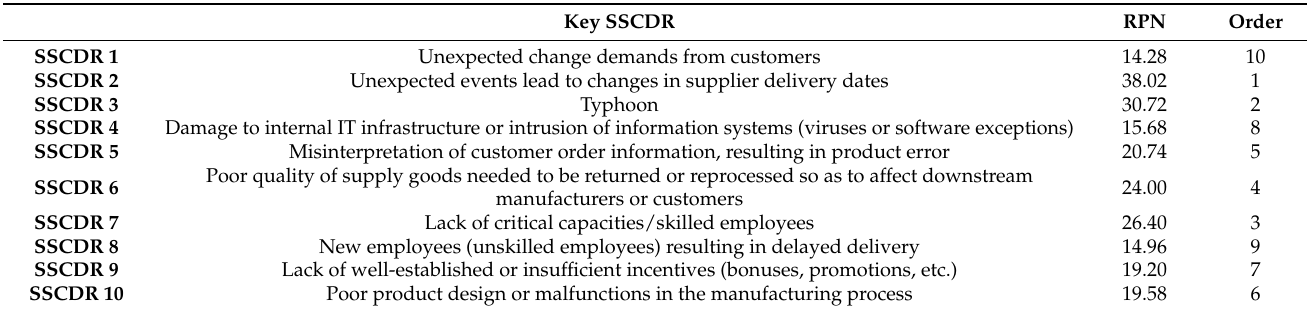
Table 3. FMEA screening results of key SSCDRs and RPNs.